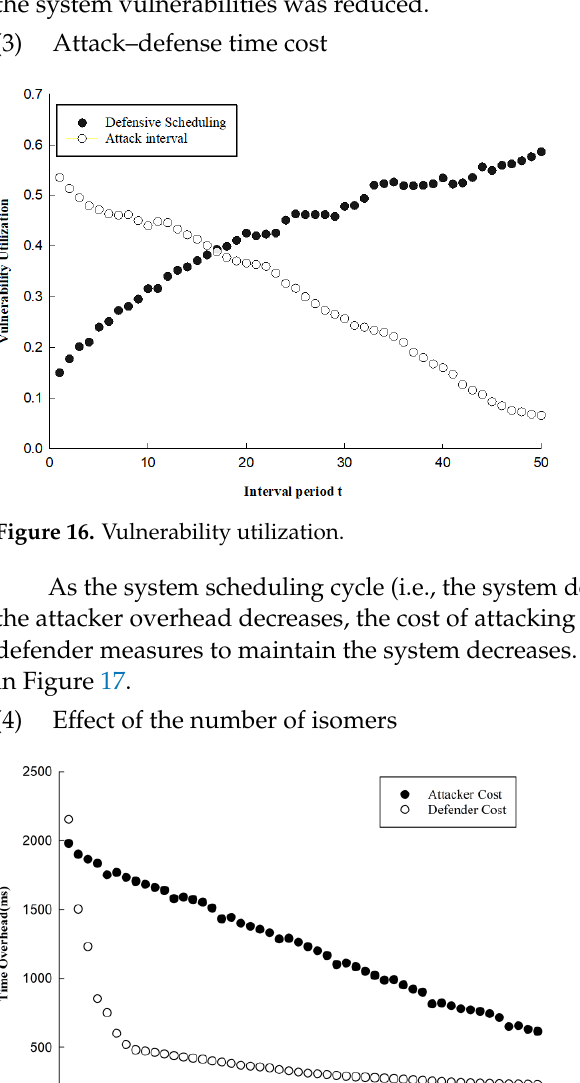
Figure 15. System failure rate.